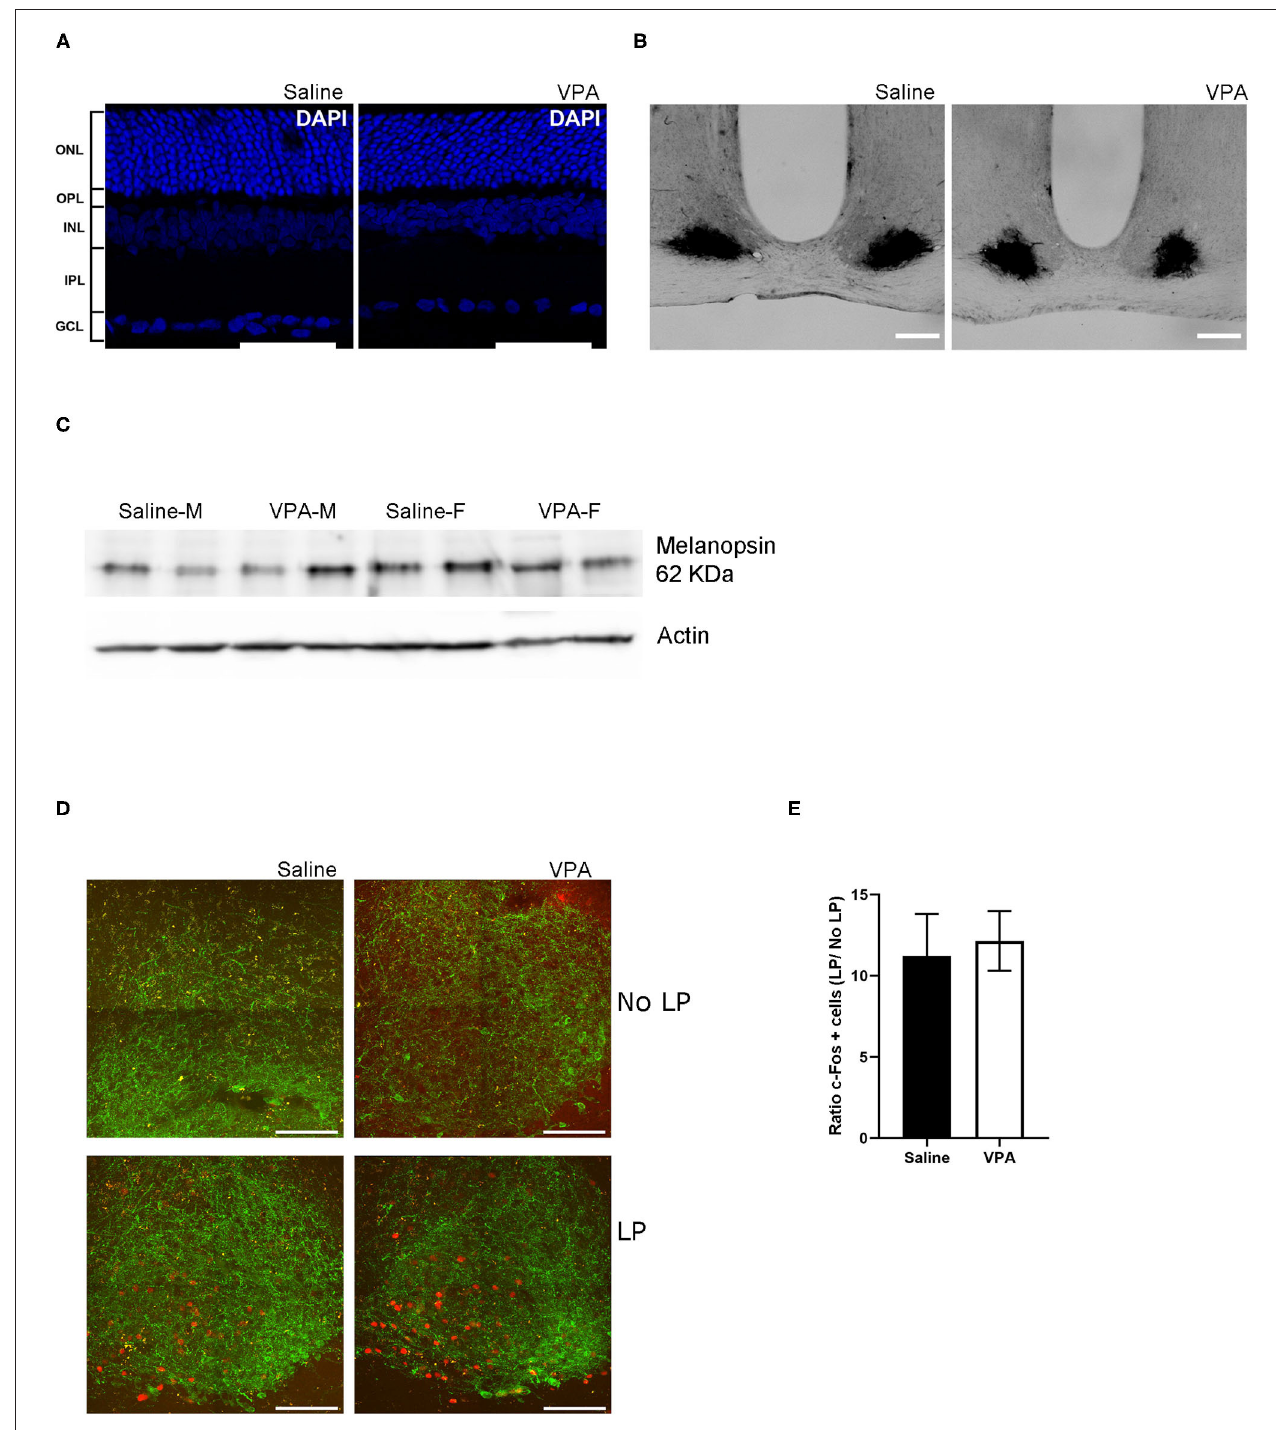
FIGURE 5 | In utero VPA exposure does not alter retinal organisation. (A) Immunofluorescent staining for the nuclear marker, DAPI in saline and VPA-exposed animals. Note the normal organisation of all five layers of the retina [outer nuclear layer (ONL), outer plexiform layer (OPL), inner nuclear layer (INL), inner plexiform layer (IPL) and ganglion cell layer (GCL)] Scale bar = 100 µ m. (B) p75-NTR immunoreactivity in the SCN of saline ( n = 3) and VPA ( n = 3) exposed animals. (C) Western blot from retinal lysates from saline and VPA-exposed male/female animals collected between ZT1-3 under standard 12:12 conditions. Note the presence of melanopsin in all groups. (D) Immunofluorescent images of c-FOS (red) and VIP (green) in light pulse (LP) or no LP conditions. Scale bar = 100 µ m. (E) Ratio of the number of c-FOS immunoreactive cells after 1h LP/number of c-FOS immunoreactive cells after No-LP (student’s t -test, ns).